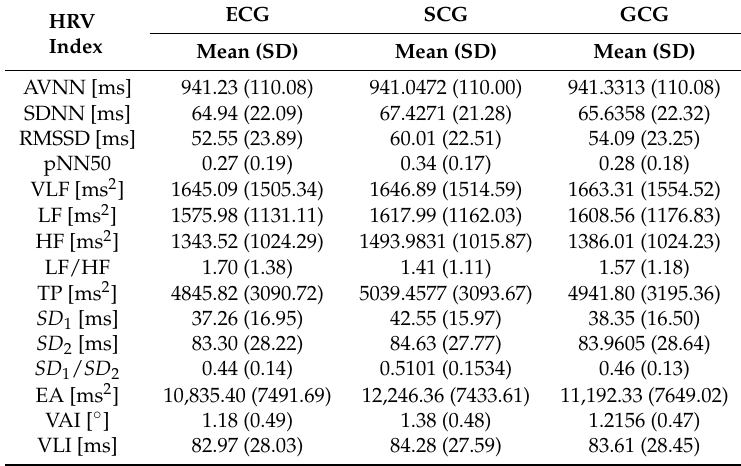
Table 3. Mean and standard deviation values of HRV indices calculated on divided into overlapping 179 s time windows.